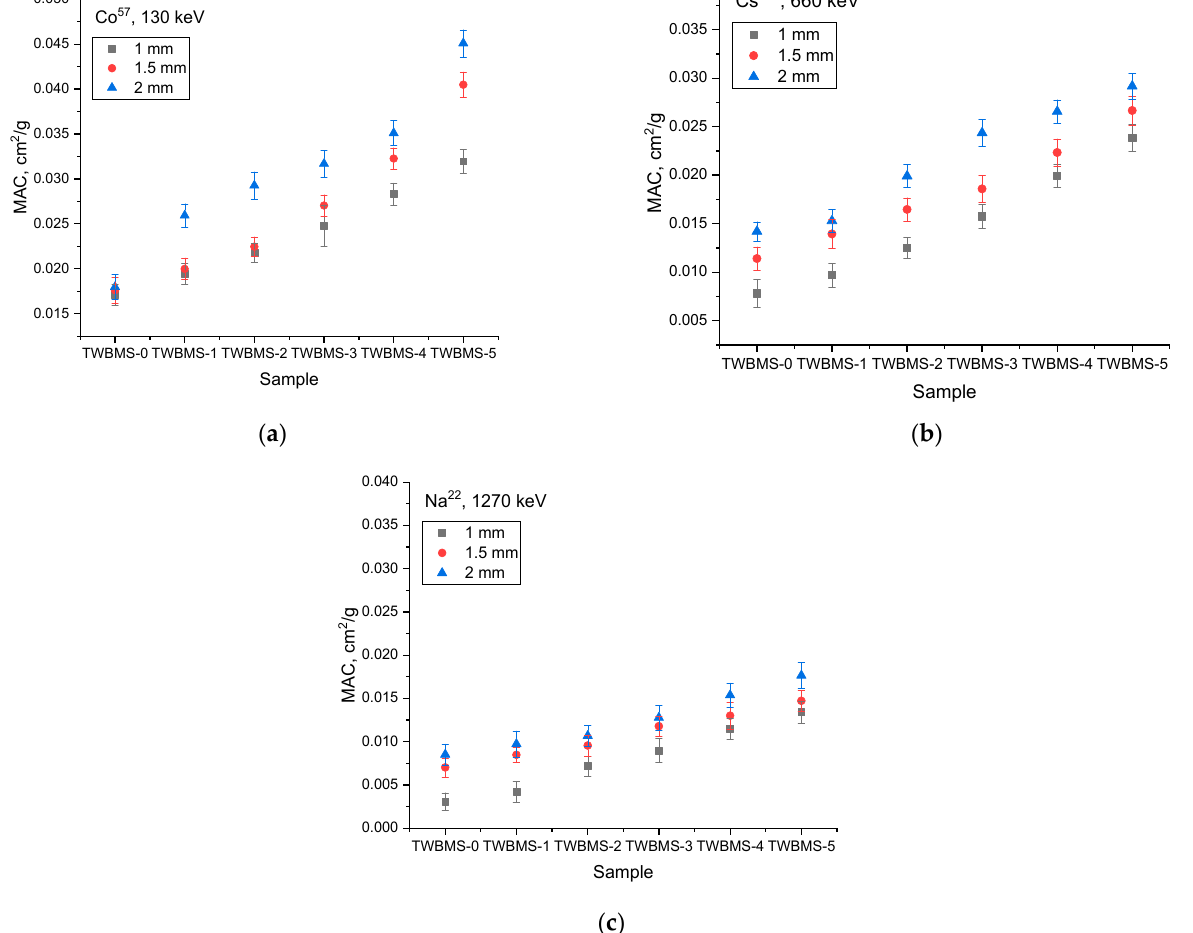
Figure 5. Results of evaluation of the change in the mass attenuation coefficient of gamma radiation depending on the type of gamma-quantum source: ( a ) Co 57 , 130 keV; ( b ) Cs 137 , 660 keV; ( c ) Na 22 , 1270 keV.